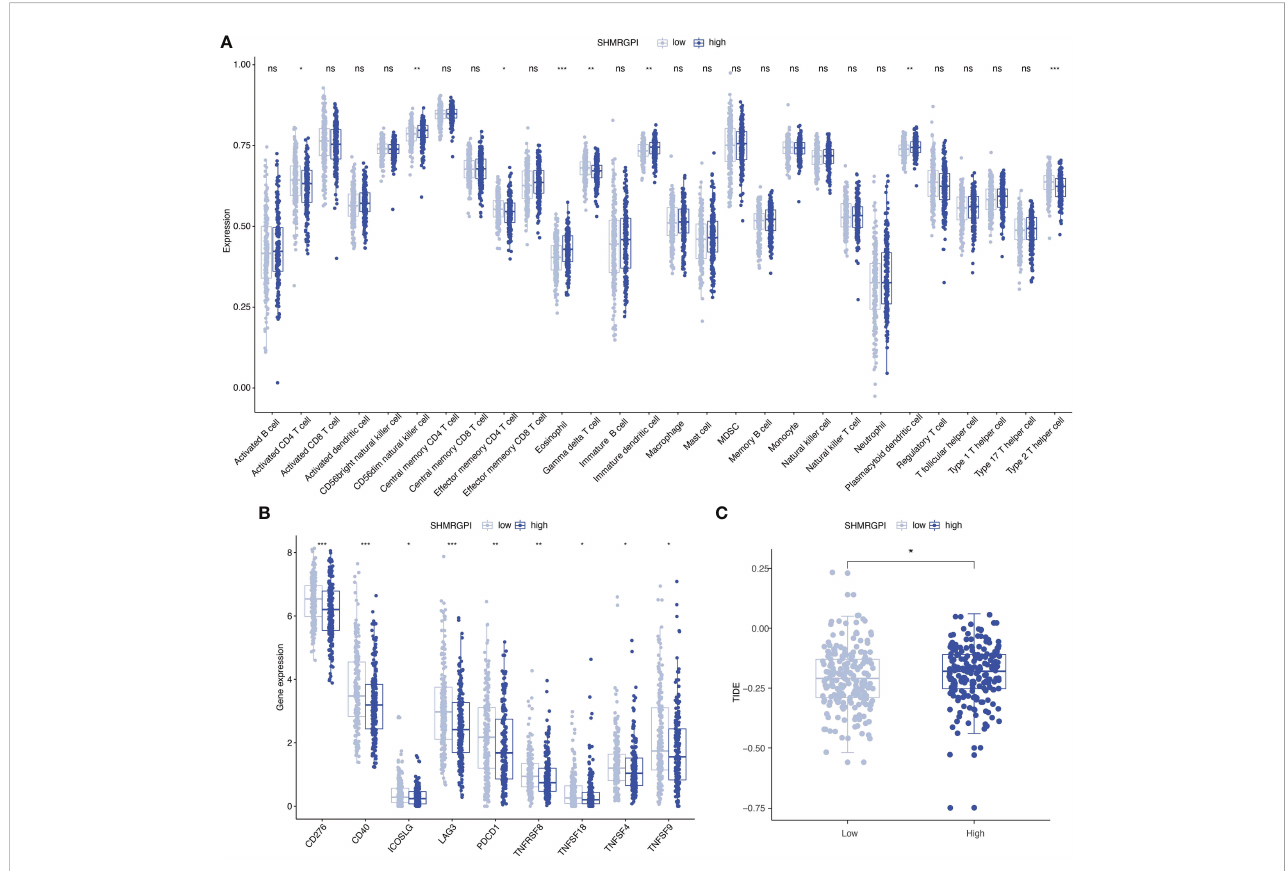
FIGURE 6 Immune correlation analysis. (A) Comparison of the discrepancy in immune cell in fi ltration between two groups based on ssGSEA. (B) Differences in the expression of immune checkpoint genes between the two groups. (C) Differences in the TIDE scores between the two groups. ssGSEA, single-sample gene set enrichment analysis; TIDE, tumor immune dysfunction and exclusion. ns, not signi fi cant. *: p value < 0.05, **: p value < 0.01, and ***: p value <